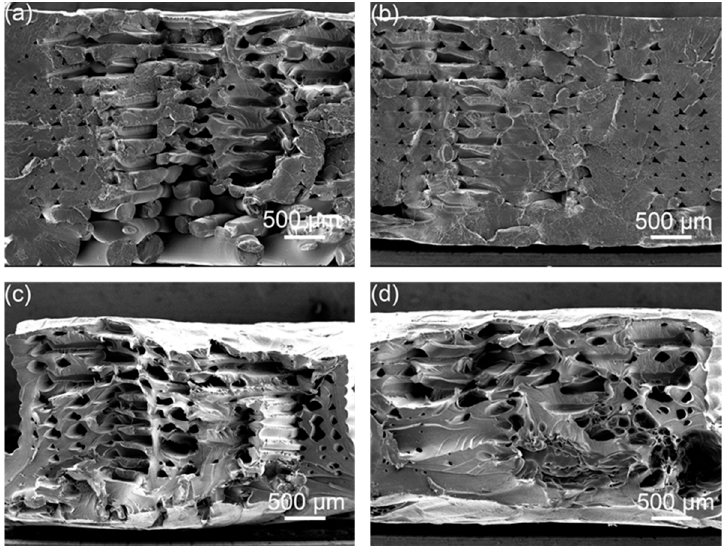
Figure 14. SEM images of the tensile specimen; ( a ) original, ( b ) first ultrasound, ( c ) second ultrasound, ( d ) fourth ultrasound.